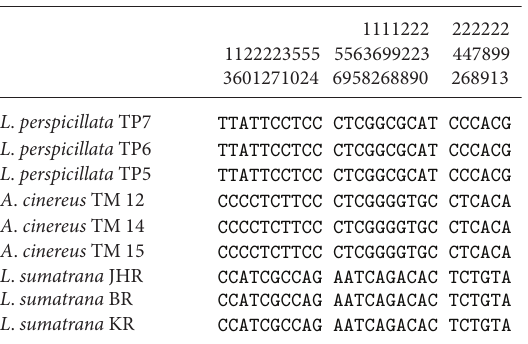
Figure 2: Polymorphic sites for L. perspicillata , A. cinereus , and L. sumatrana used to identify the